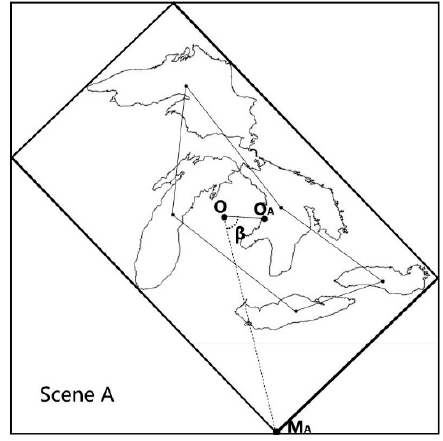
Figure 14. The center angle of Scene A .